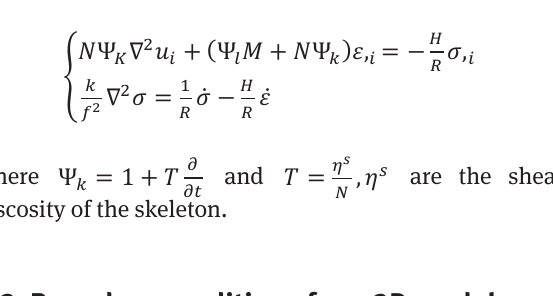
in the examined cross-section. Fig. 8 shows the distribution of stresses in the liquid (pore stresses) after the consolidation process – fp a ss. According to the accepted boundary condition, the stresses at the groundwater level and above are equal to, where f denotes porosity and p the atmospheric pressure. a